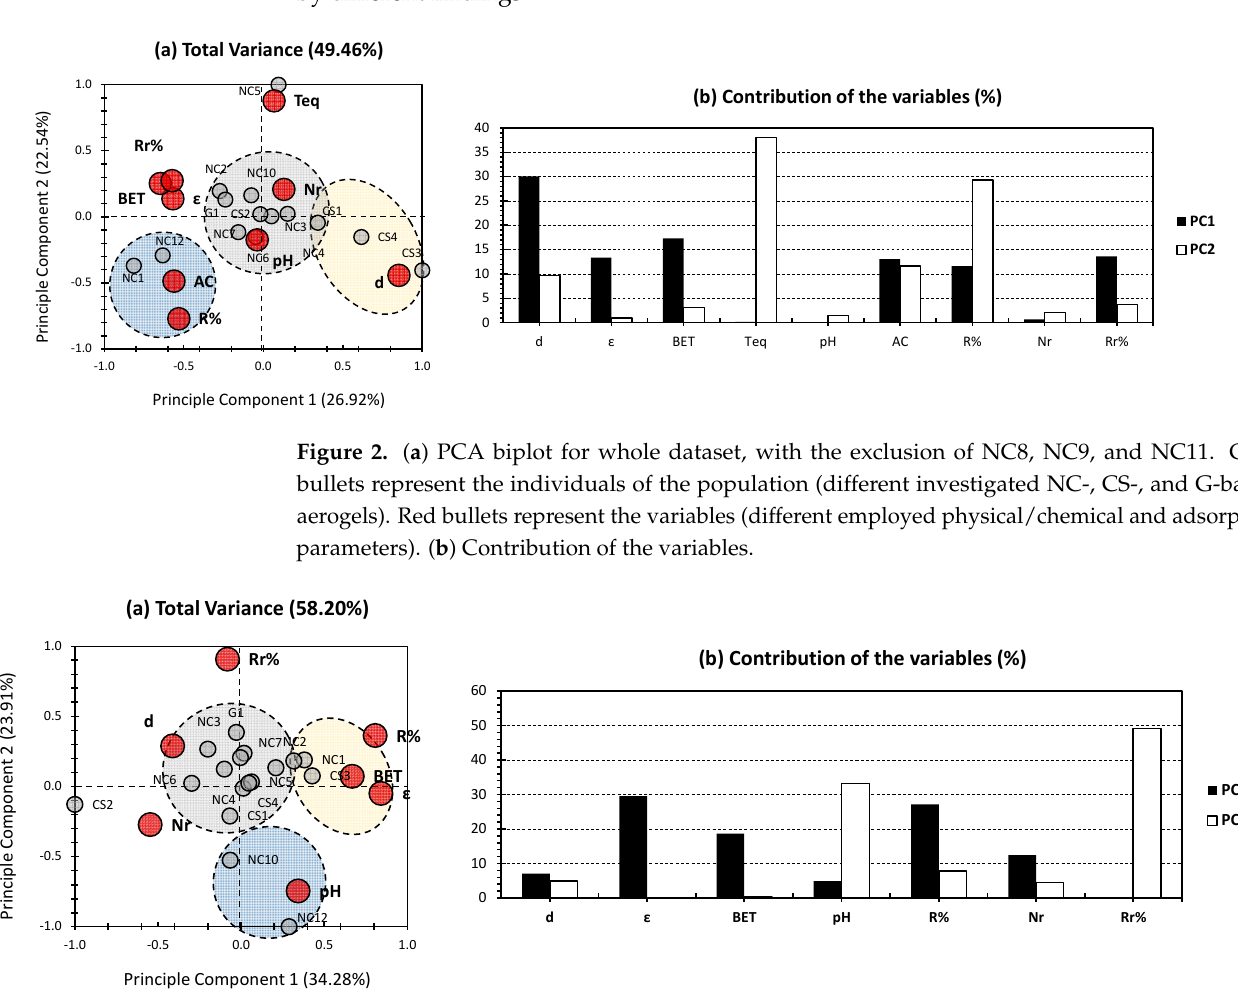
Figure 3. ( a ) PCA biplot for whole dataset, with the exclusion of Teq and AC from the variables. Gray bullets represent the individuals of the population (different investigated NC-, CS-, and G-based aerogels). Red bullets represent the variables (different employed physical/chemical and adsorption parameters). ( b ) Contribution of the variables.